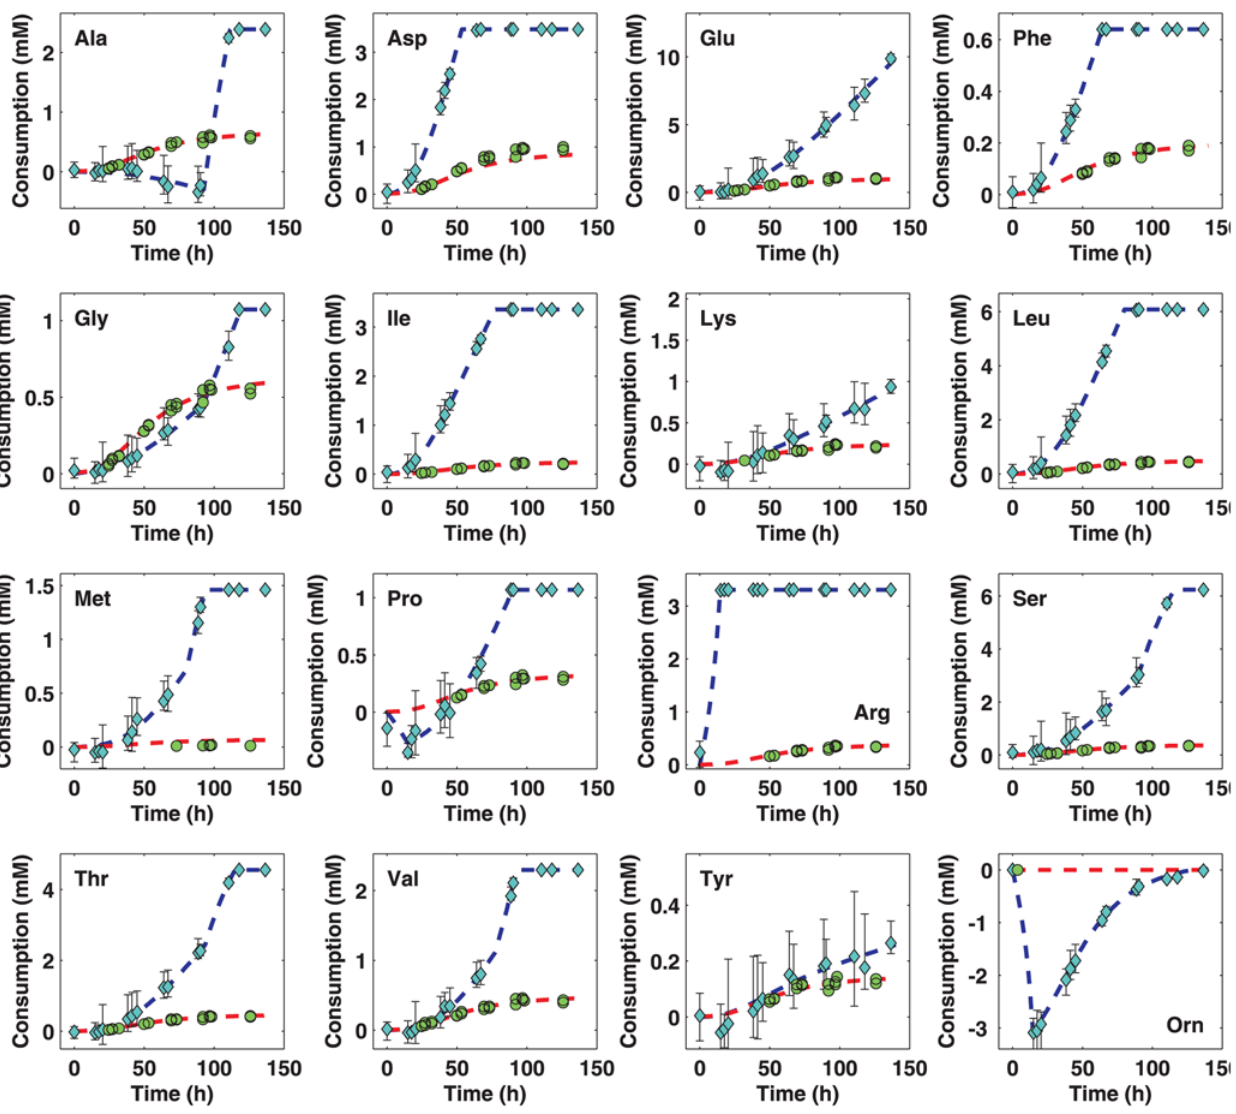
Figure 4. Summary of nutrient uptake and incorporation rates under aerobic conditions. The blue curves indicate the net amount of each amino acid that has been consumed (positive) or produced (negative) as a function of time. The red curves, on the other hand, show the total amount of each that has been incoporated into the biomass, whether integrated into proteins or as free metabolites. Clearly, for most of the supplied amino acids, the rate at which they are taken up from the medium far exceeds the rate at which they are directly incorporated. This implies that the pertinent amino acids are, in addition, significantly catabolized for energy, and/or are used to synthesize the other biomass constituents that are not